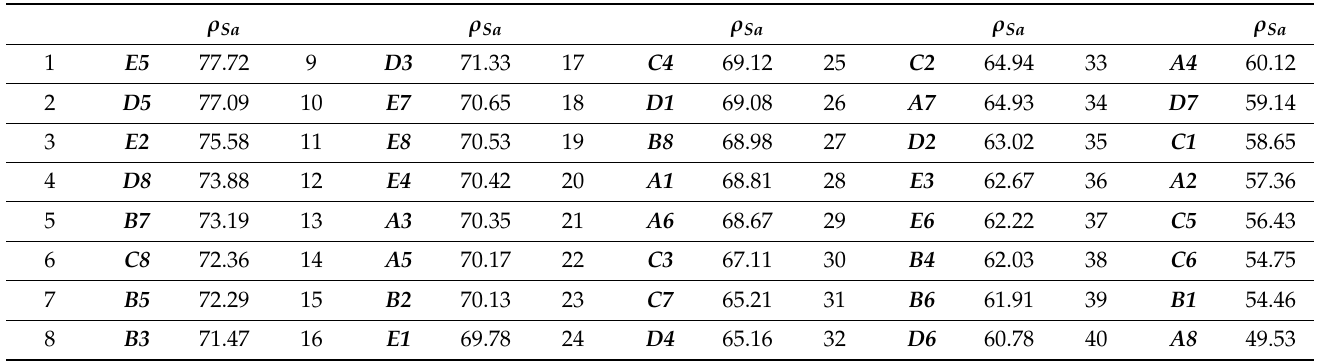
Table 12. The sequence formation based on improvement ratios for S a .